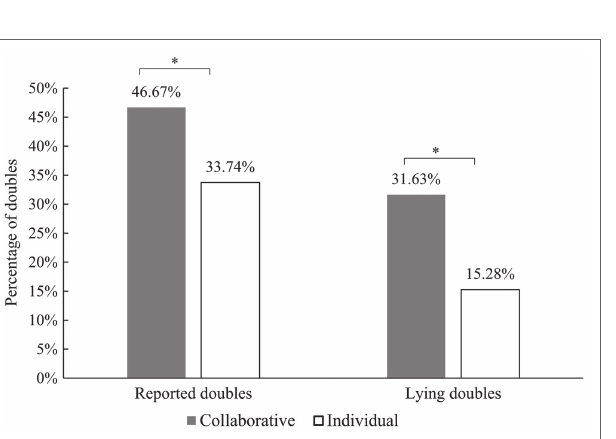
FIGURE 3 | The percentage of reported doubles and the percentage of reports that were lies in both conditions. * p <